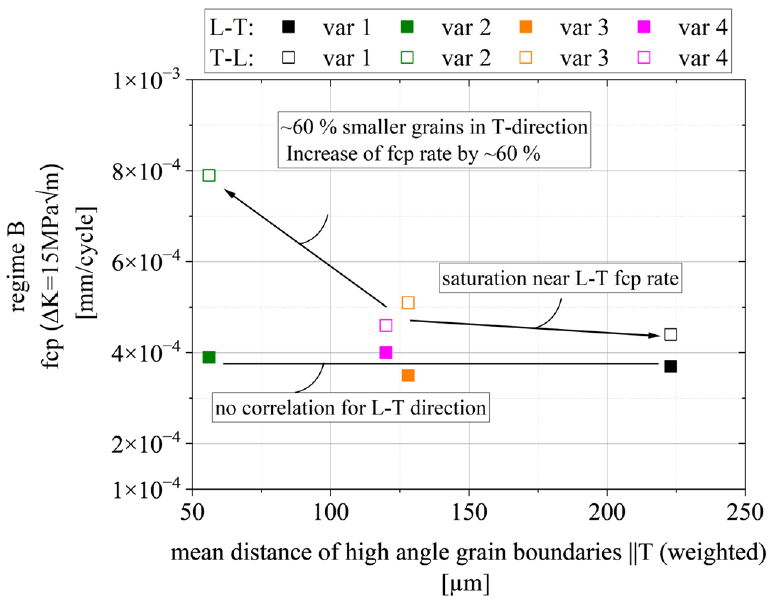
Figure 15. Correlation of the crack growth rate in regime B and the mean weighted distance of high angle grain boundaries in the T direction.